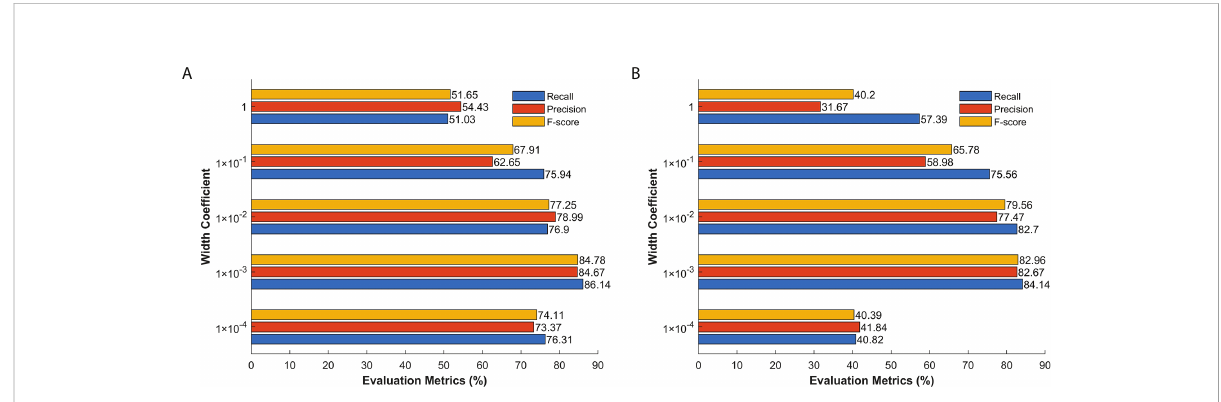
FIGURE 5 Average classi fi cation performance in WV1 (A) and WV2 (B) imagette classi fi cation of KECANet equipped with different width coef fi cients.